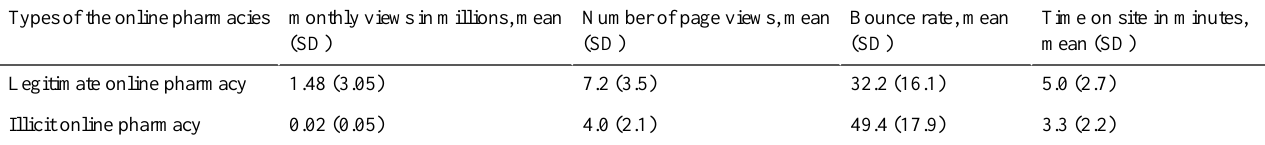
Table 6. Consumers’engagement with online pharmacies.